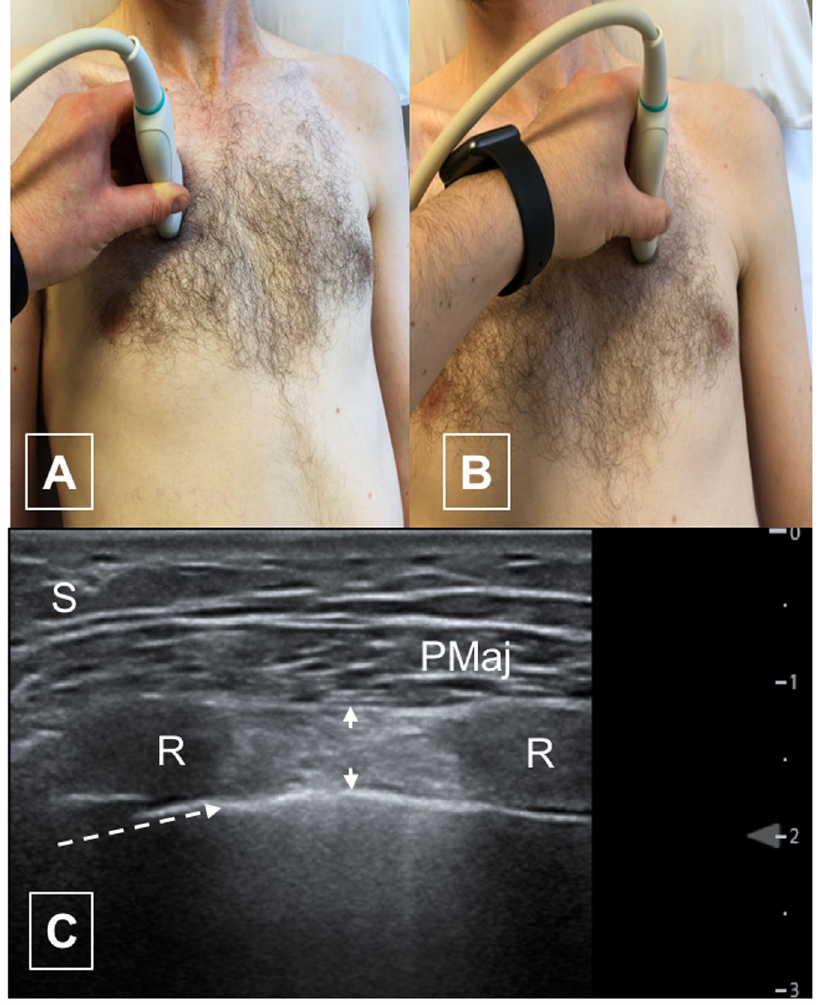
Figure 1. Parasternal intercostal ultrasound. ( A ) Position of probe for right second intercostal space. ( B ) Position of probe for left second intercostal space. ( C ) Typical ultrasound image of parasternal intercostal muscle (left 2 nd intercostal space. S – subcutaneous fat PM – pectoralis major muscle. R – rib Arrow heads – outline of intercostal muscle. Dotted arrow – pleural